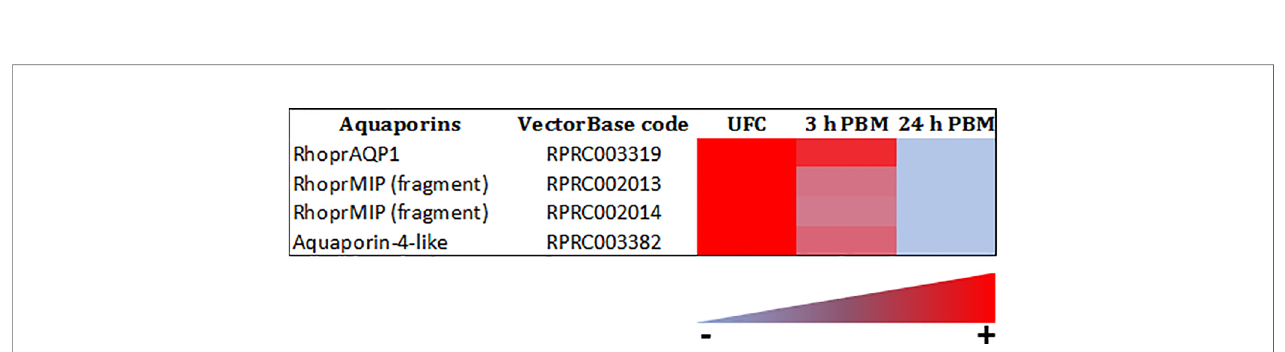
FIGURE 11 | Heat map comparing the mRNA expression levels of aquaporins in Malpighian tubules from insects unfed (UFC), 3 h and 24 h post blood meal (PBM). The input data is the readcount value from gene expression level analysis after normalization and is presented by means of a color scale, in which light blue/red represent lowest/highest expression. DESeq was used to perform the analysis. Details of transcript expression are shown in Supplementary Worksheets 1 , 2 .